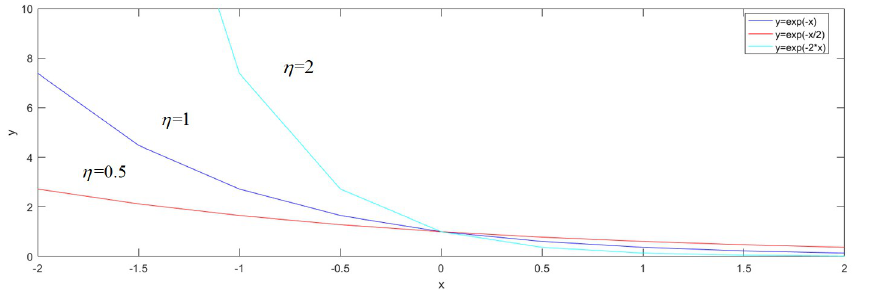
Fig 9. The graph of e (cid:0) η p i with different values of η